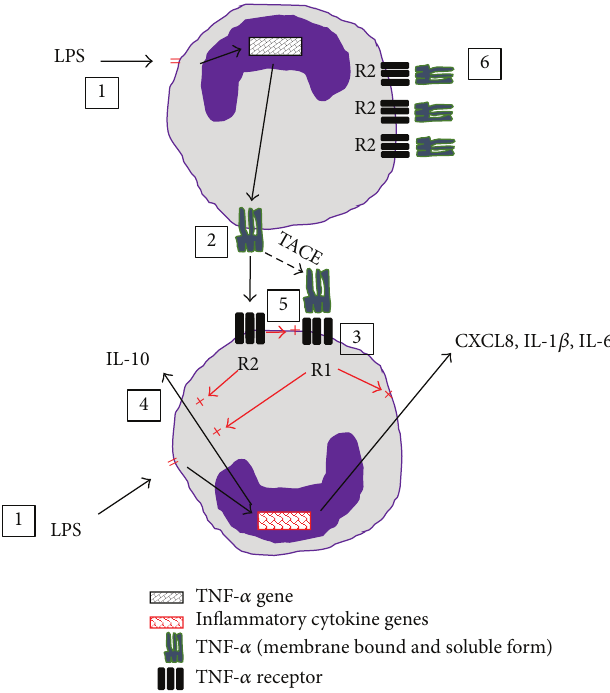
Figure 7: TNF- 𝛼 effects on monocytes via TNR1 and TNFR2. The figure shows two adjacent monocytes. (1) LPS induces both pro- and anti-inflammatory cytokine gene/protein expression. (2) TNF- 𝛼 , induced by LPS stimulation, is expressed at the monocyte surface as mTNF- 𝛼 and cleaved to sTNF- 𝛼 by the enzyme TACE. (3) sTNF- 𝛼 signals in an autocrine/paracrine fashion via TNFR1 to augment the expression of CXCL8, IL1- 𝛽 , IL-6, and IL-10 mRNA and (4) mTNF- 𝛼 via TNFR2 to further augment IL-10 mRNA expression. (5) Autocrine/paracrine binding of membrane TNF- 𝛼 to TNFR2 also upregulates the expression of TNFR1 at the cell surface. (6) TNFR2 binds sTNF- 𝛼 . Selective TNFR1 blockade will switch off TNF- 𝛼 driven proinflammatory cytokine production whilst leaving TNFR2 free to upregulate the immunoregulatory cytokine, IL-10, and possibly clear a proportion of sTNF- 𝛼 from the pericellular